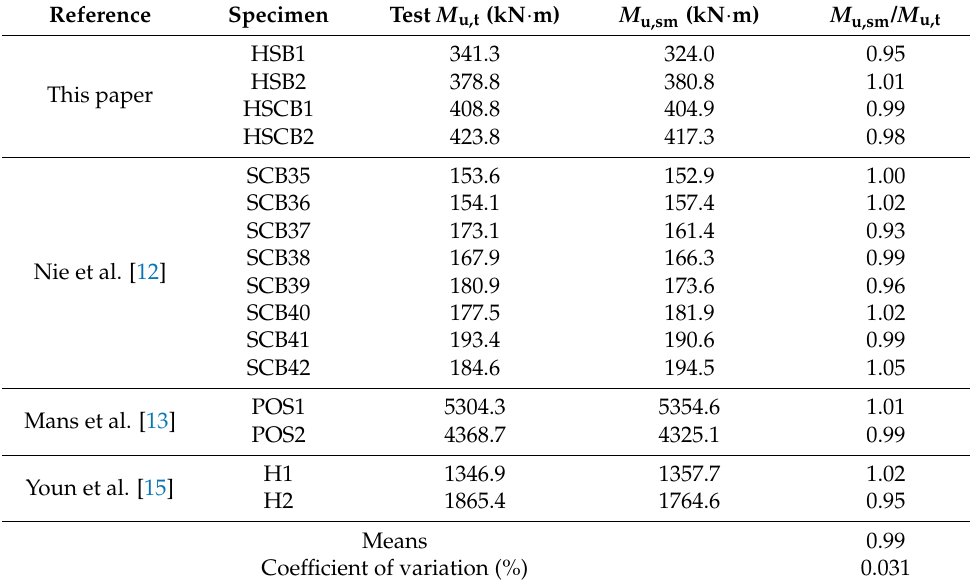
Table 5. Comparison between experimental and theoretical results of modified plastic method.